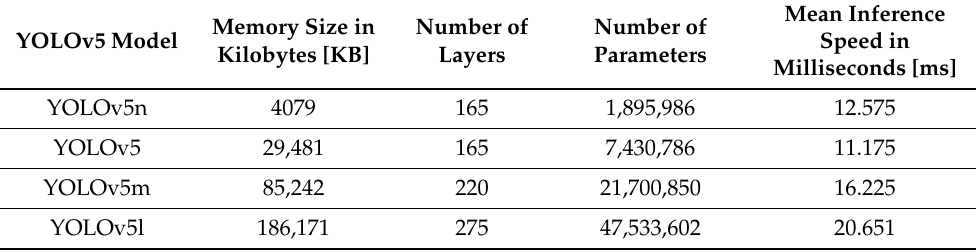
Table 9. Final concluding discussion and selection of a model for